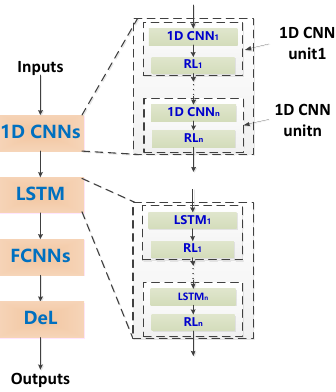
Figure 3. The deep-learning-based detection model proposed in this paper.